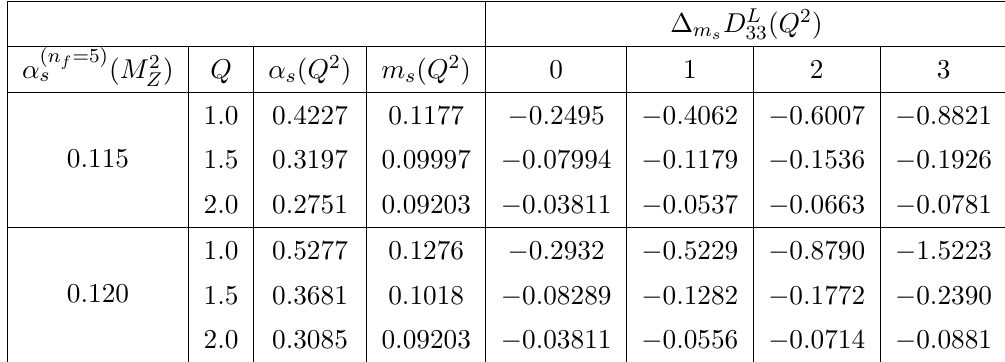
Table 2 . Values of α s ( Q 2 ) and m s ( Q 2 ) with n f = 3 (left) for several choices of Q (GeV units) and α ( n f =5) s